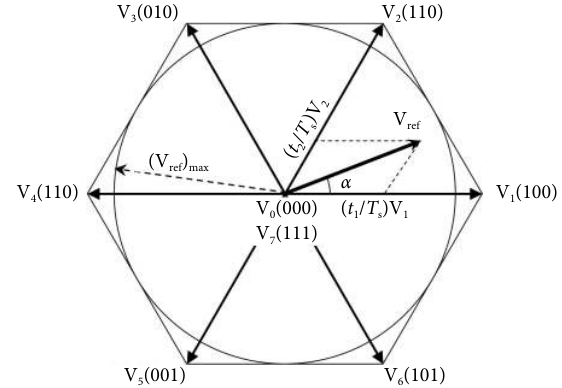
Fig. 25 Diagram of SVPWM